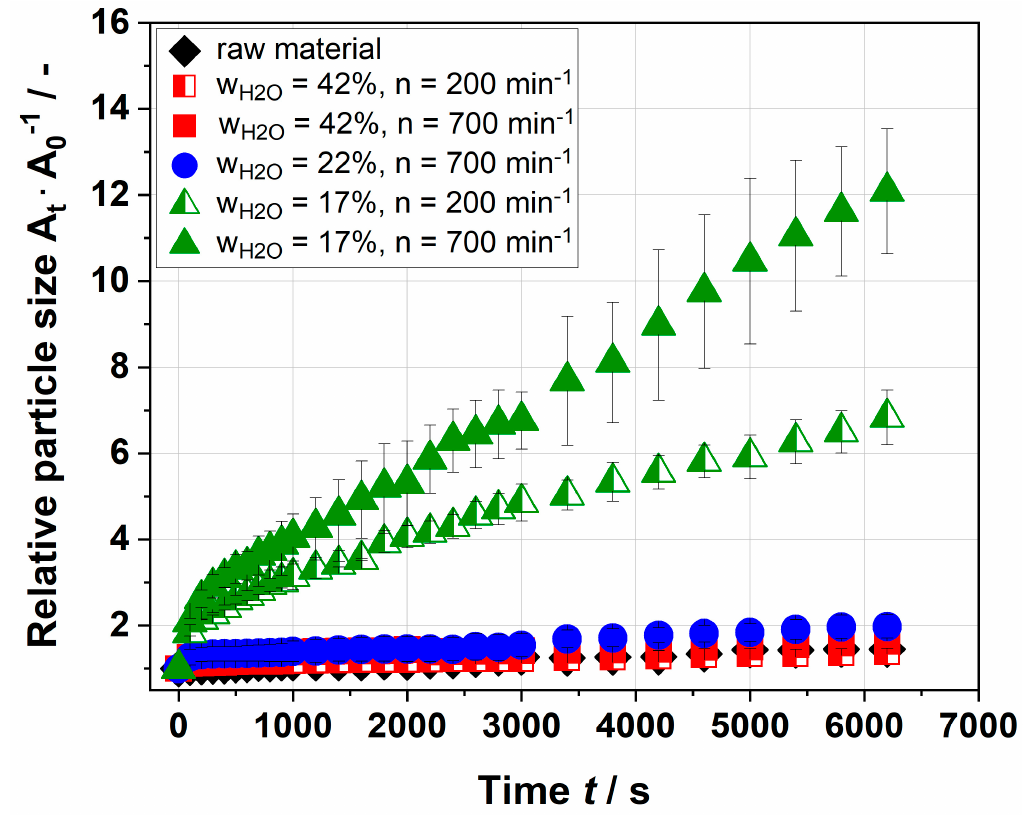
Figure 7. Growth of insoluble particles in water by microscopic image analysis. The extrusion process parameters of the extruded sample were water contents of 42 and 17%, and a screw speed of 700 min − 1 . The relative particle size A t · A 0 − 1 is the area a particle covers at time t divided by the initial area a particle covers at time t = 0